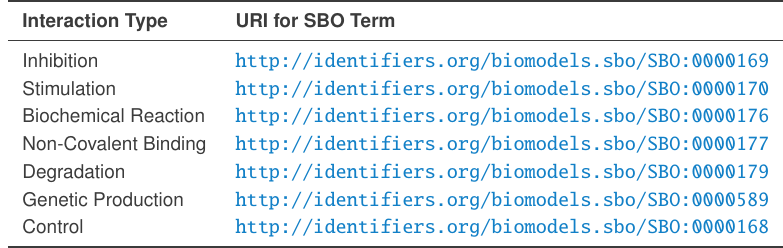
Table 13: SBO terms to specify the types property of an Interaction